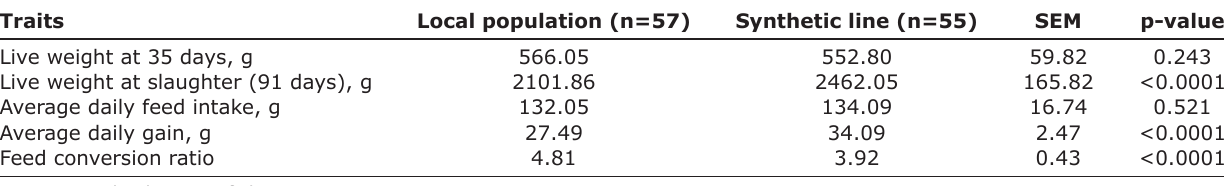
SEM=Standard error of the